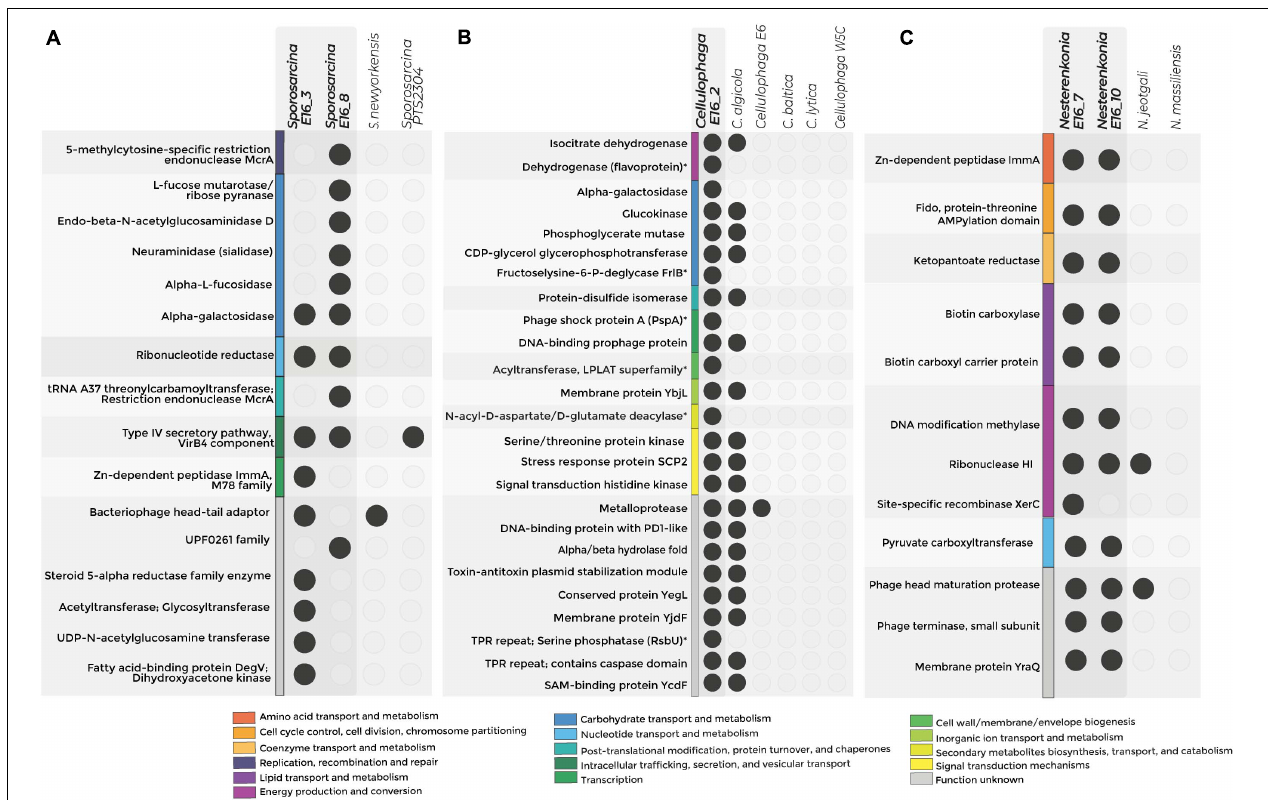
FIGURE 4 | Exclusive COGs detected in the genome of host-associated bacteria. The figure shows the exclusive COG for Sporosarcina (A) , Cellulophaga (B) , and Nesterenkonia (C) . Colors represent categories of exclusive COGs, and empty circles denote the absence of the COG in the genome. * p -value < 0.05—functions without statistical